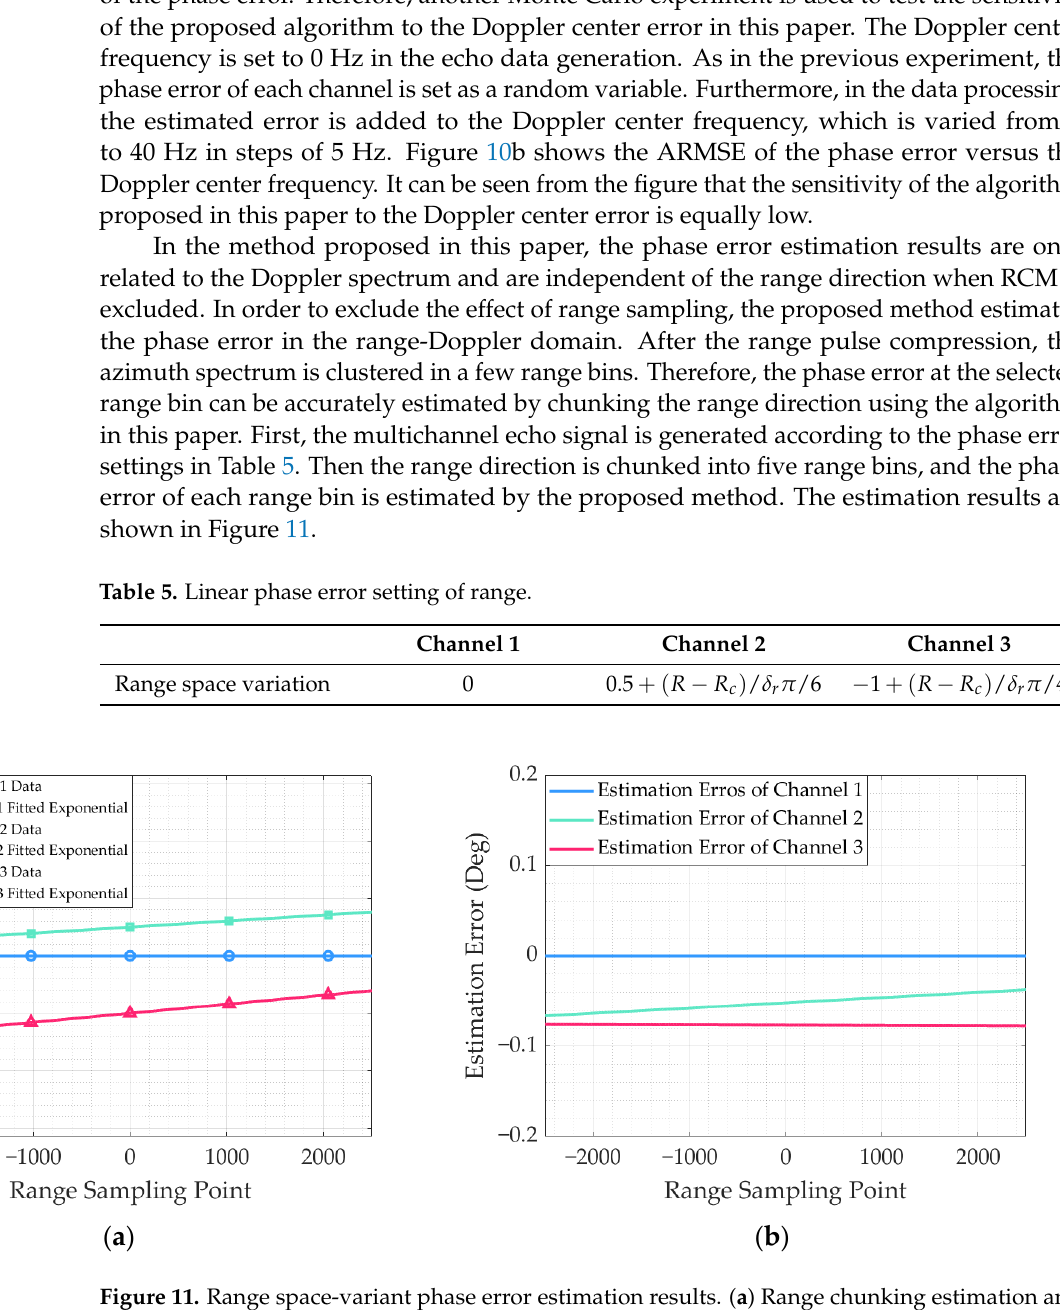
Figure 10. Comparison of stability of different estimation methods. ( a ) ARMSE of the phase error versus SNR. ( b ) ARMSE of the phase error versus Doppler center frequency.